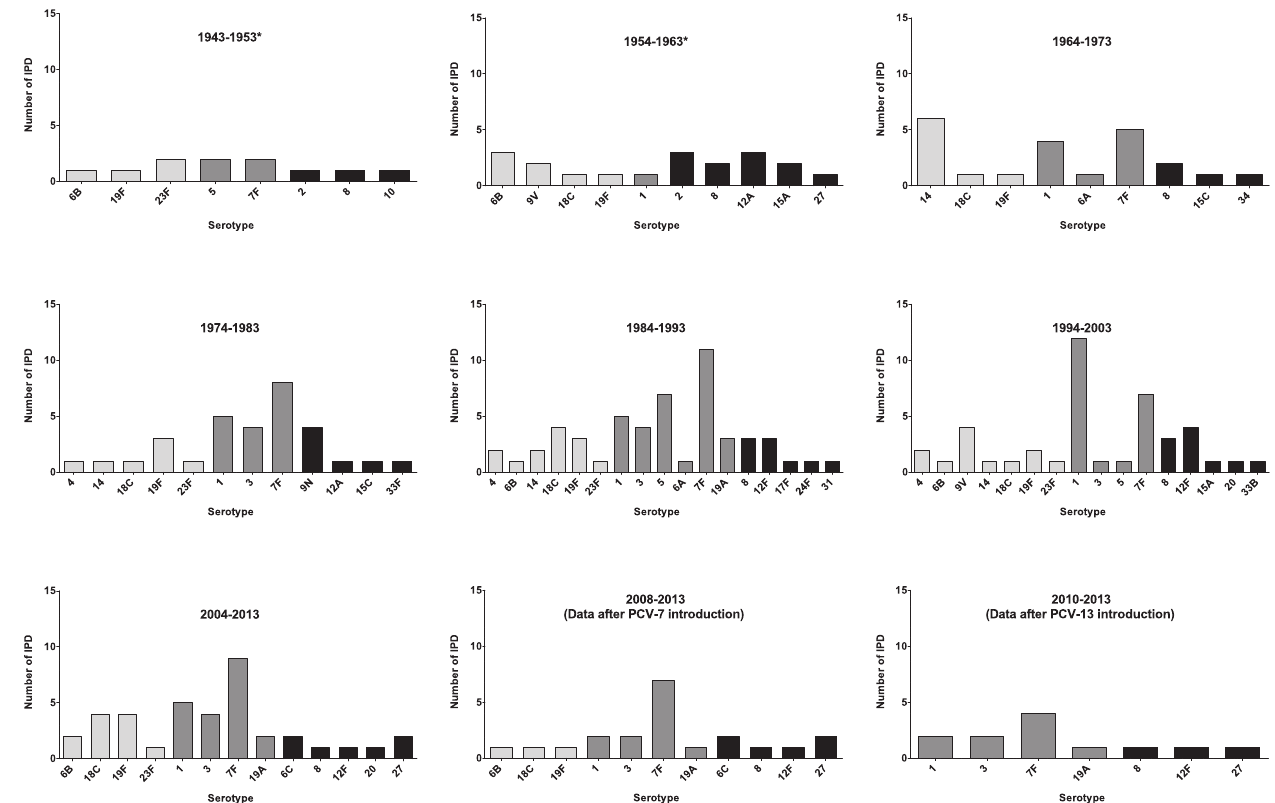
Figure 4. IPD serotypes observed in infants less than 90 days from 1943 through 2013. Light grey bars represent serotypes included in the PCV-7. Grey bars represent serotypes included in the PCV-13. Black bars represent non-vaccine serotypes. *Identification of isolates in the early years has to be considered with precaution.